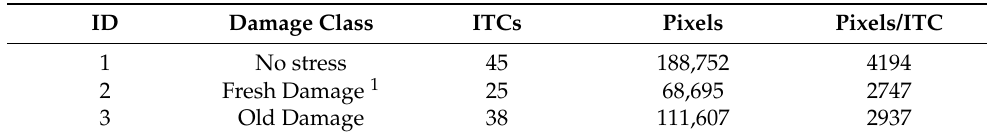
Table 2. Damage class for sample redwood trees, the total number of pixels, the number of individual tree crowns (ITCs), and the average number of pixels per individual tree crown. ID Damage Class ITCs Pixels Pixels/ITC 1 No stress 45 188,752 4194 2 Fresh Damage 1 25 68,695 2747 3 Old Damage 38 111,607